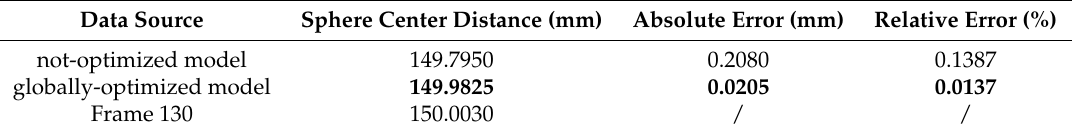
Table 2. Sphere center distance fitting results with the absolute and relative errors relative to the ground